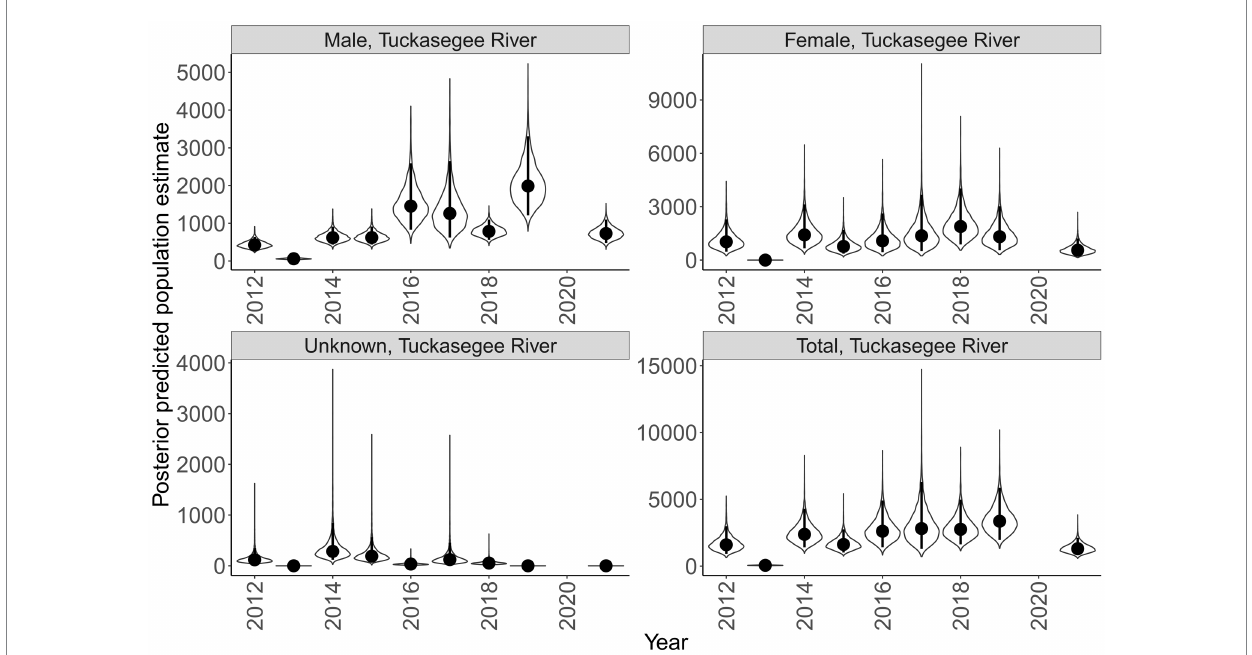
FIGURE 8 Annual population estimate of Sicklefin Redhorse Moxostoma sp. in the Tuckasegee River by sex and all sexes combined. Years without a plot indicate river was not sampled. Violin plots represent the shape of the full posterior distribution, dark circles represent the median of the posterior distribution, and solid vertical lines represent the bounds of the 95% credible